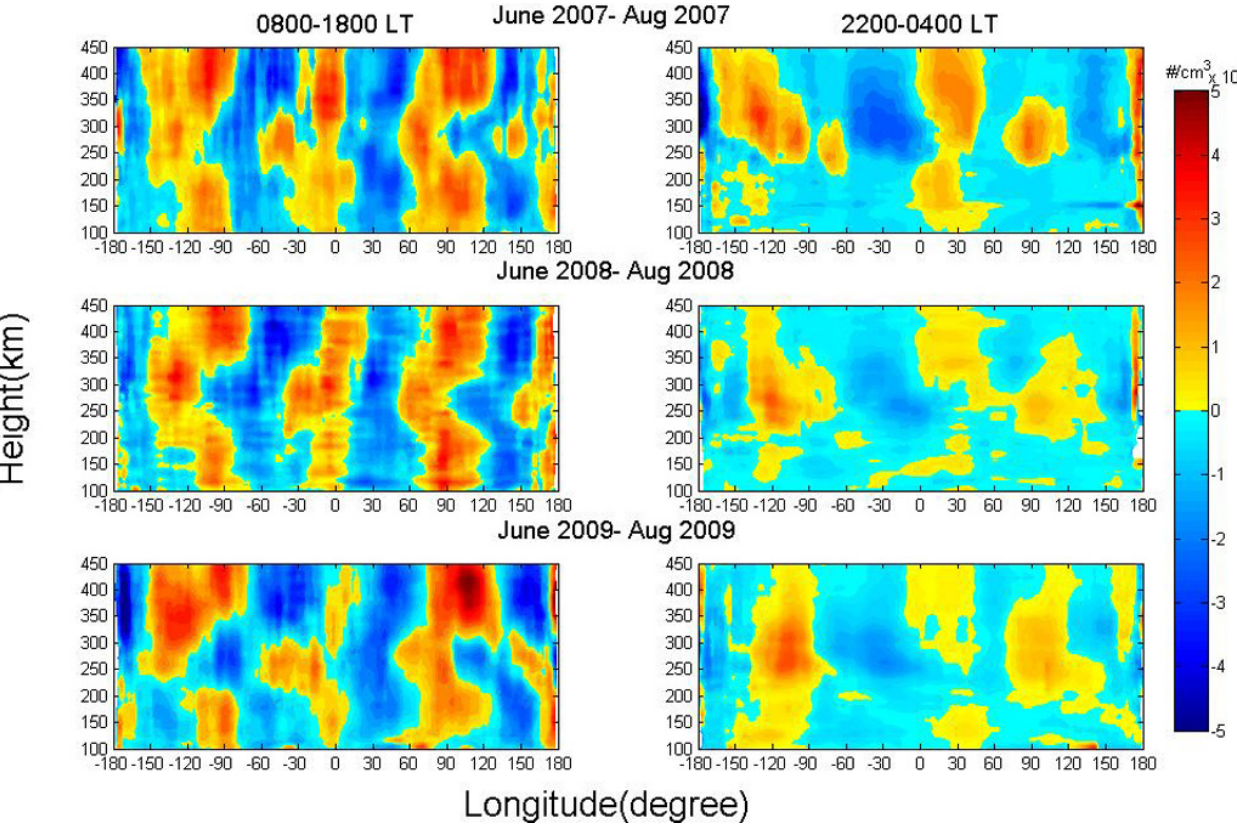
Fig. 5. Same as Fig. 2 but for June solstice in 2007, 2008, and